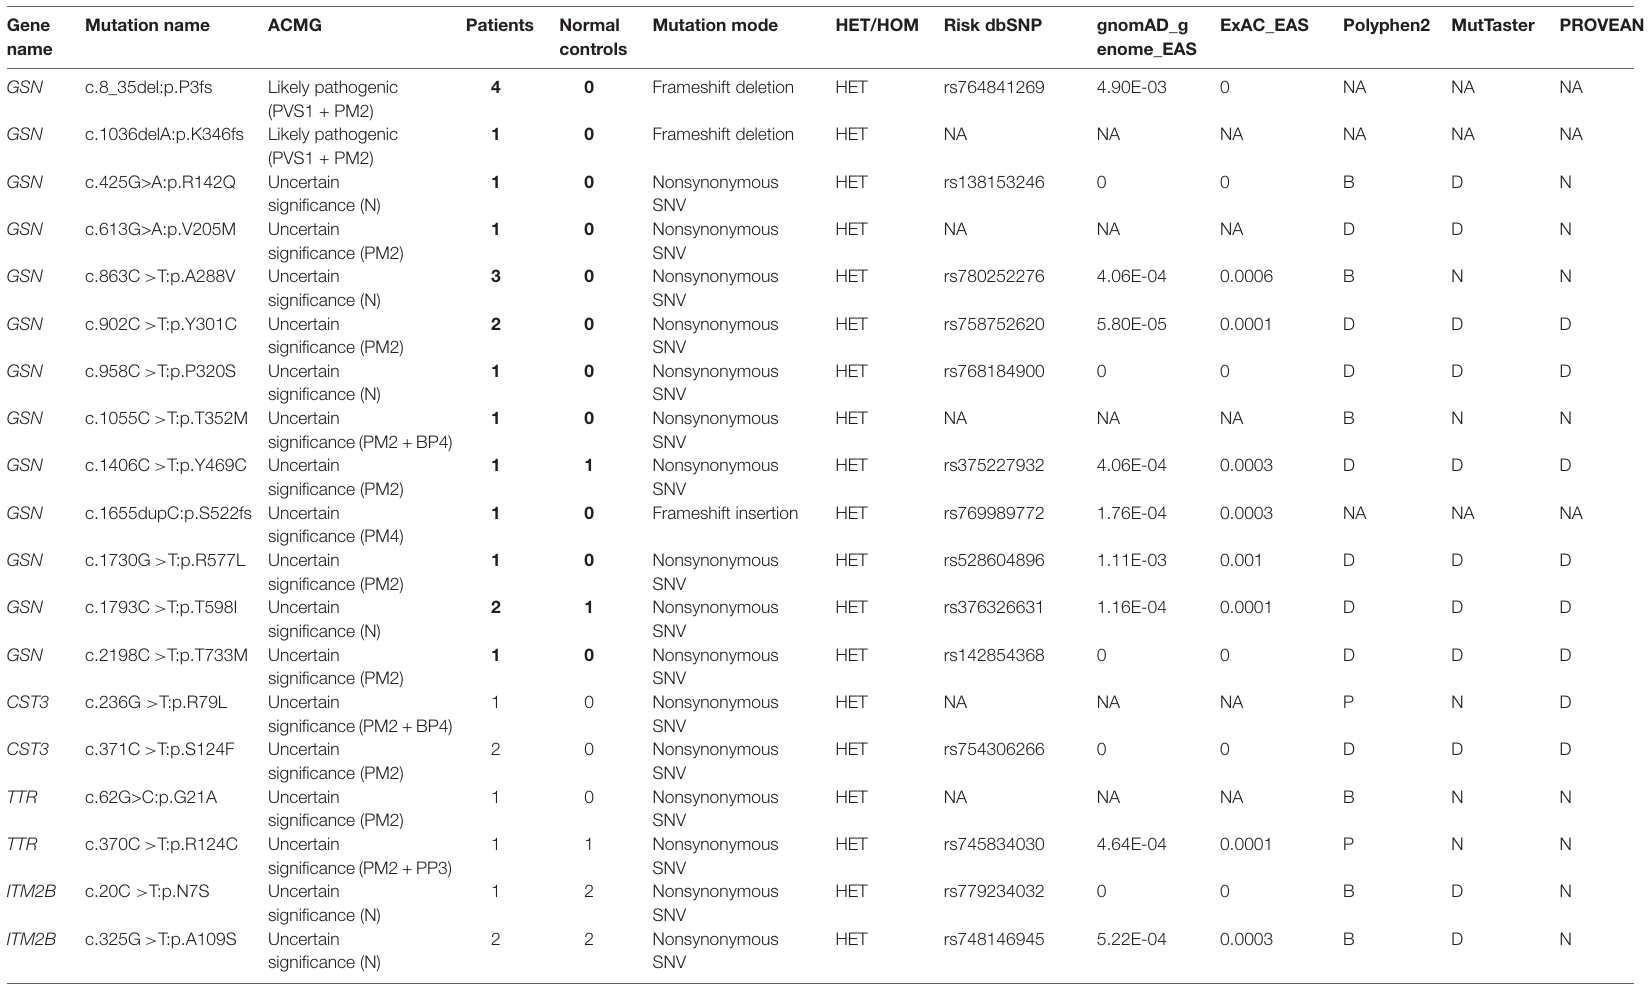
TABLE 2 | Variants in genes of gelsolin ( GSN ), cystatin C ( CST3 ), transthyretin ( TTR ), and integral membrane protein 2B ( ITM2B